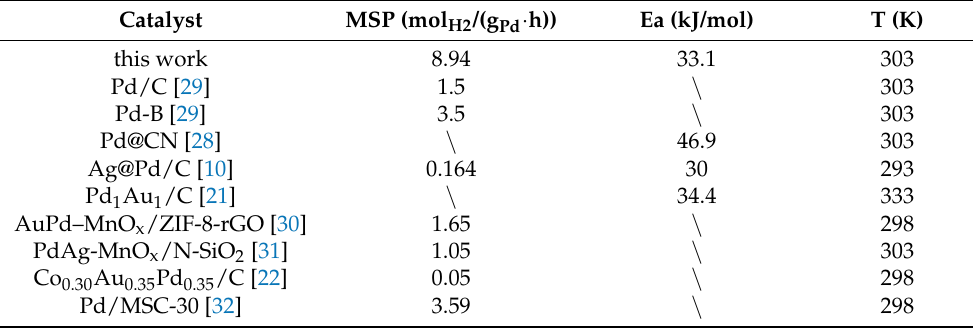
Table 1. Comparison of the mass-specific performance (MSP) and activation energy (Ea) between different types of reported catalysts with the catalyst prepared by coupling pre-nucleation and in situ reduction in this